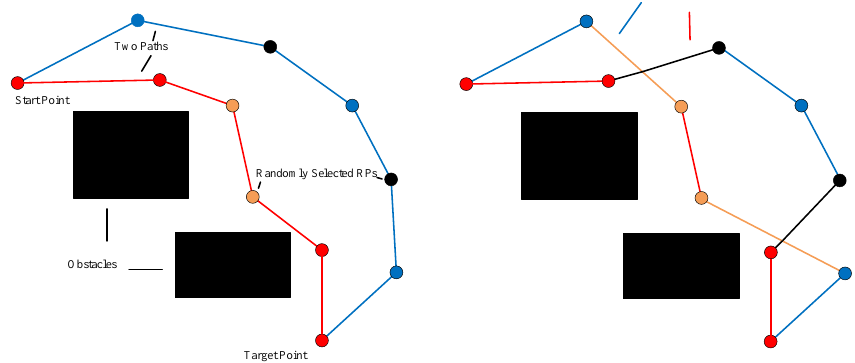
Figure 2. The crossover operator is shown. In the left sub-figure, the yellow circles are the two rotation points randomly selected on the path. Similarly, the black circles are the two rotation points on the other path. The line segments between the yellow circles are exchanged with the line segments between the black circles. Finally, two new paths are generated and displayed in the right